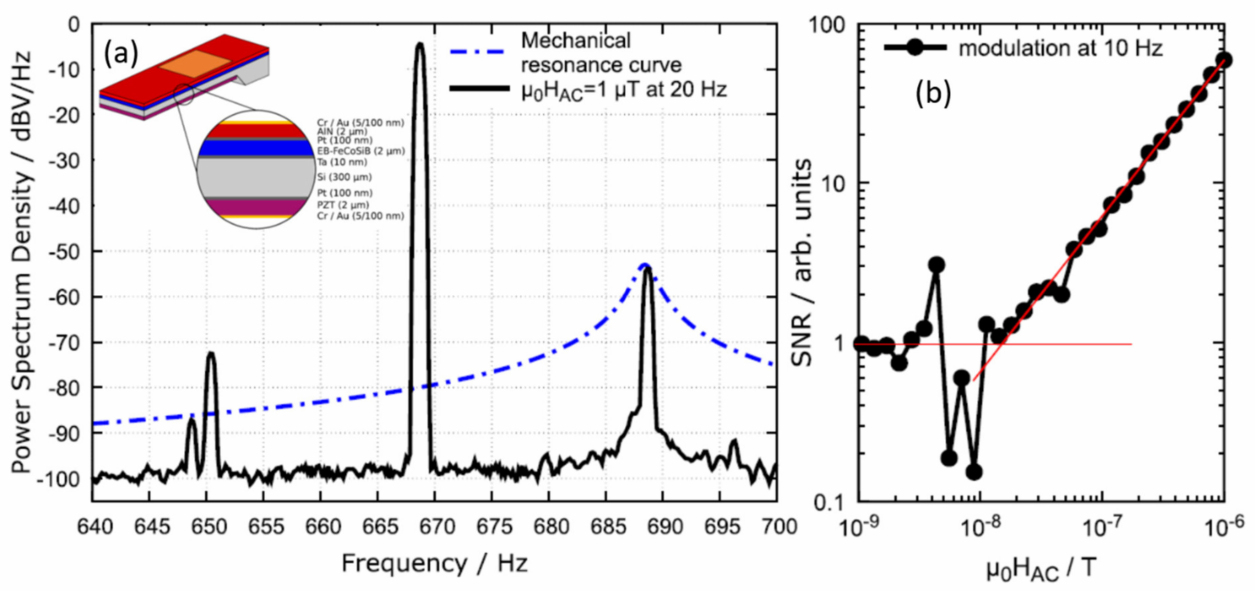
Figure 6. ( a ) Output spectrum of AIN/FeCoSiB/PZT sensor with f mod at 669 Hz. A 20 Hz sinusoidal field of 1 µ T is applied to the sensor which results in the two sidebands f mod ± 20 Hz. Inset shows the fabricated ME sensor consisting of three active layers. ( b ) Linearity measurement at 10 Hz, where an LOD of 10 nT/Hz 1/2 was obtained. Reprinted with permission from ref. [34]. Copyright 2021 AIP